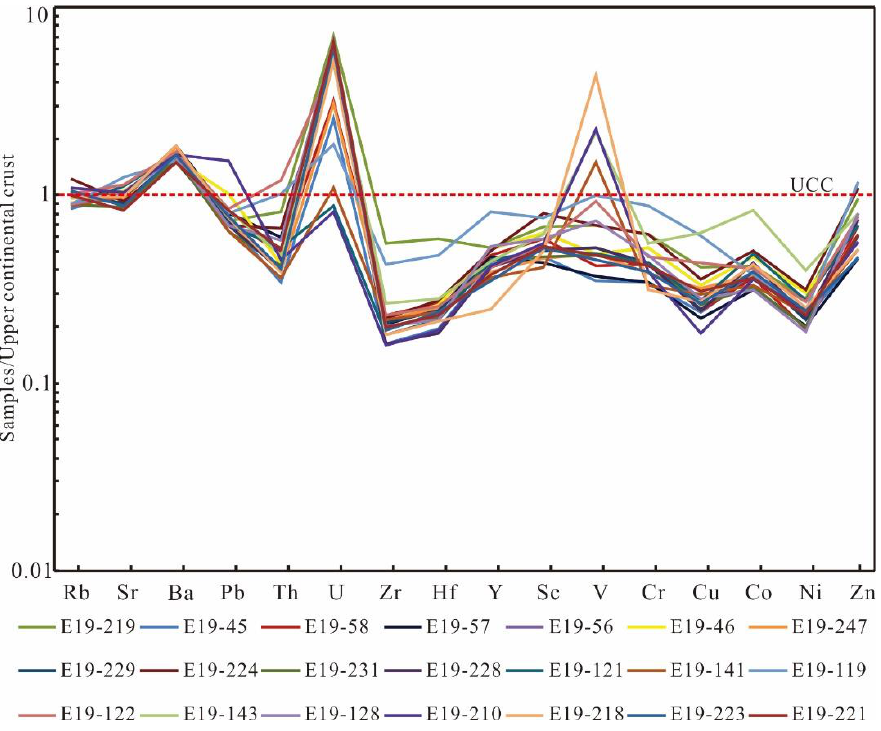
Figure 5. The standardized distribution curve of the upper continental crust of trace elements; UCC: upper continental crust is quoted from Rudnick and Gao [33].